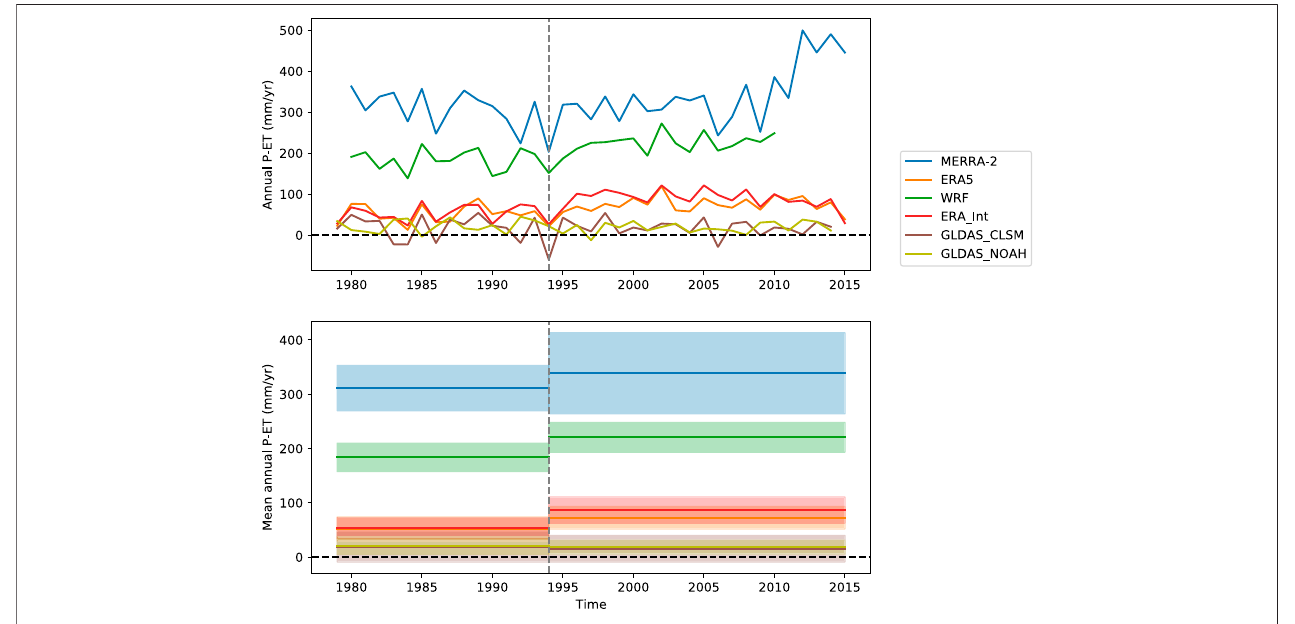
FIGURE 7 | Annual P – ET for the six reanalysis (upper panel) and mean annual P – ET (lower panel) for the whole study area. The shaded areas in the lower panel show one standard deviation of the annual series of P – ET for the period considered.